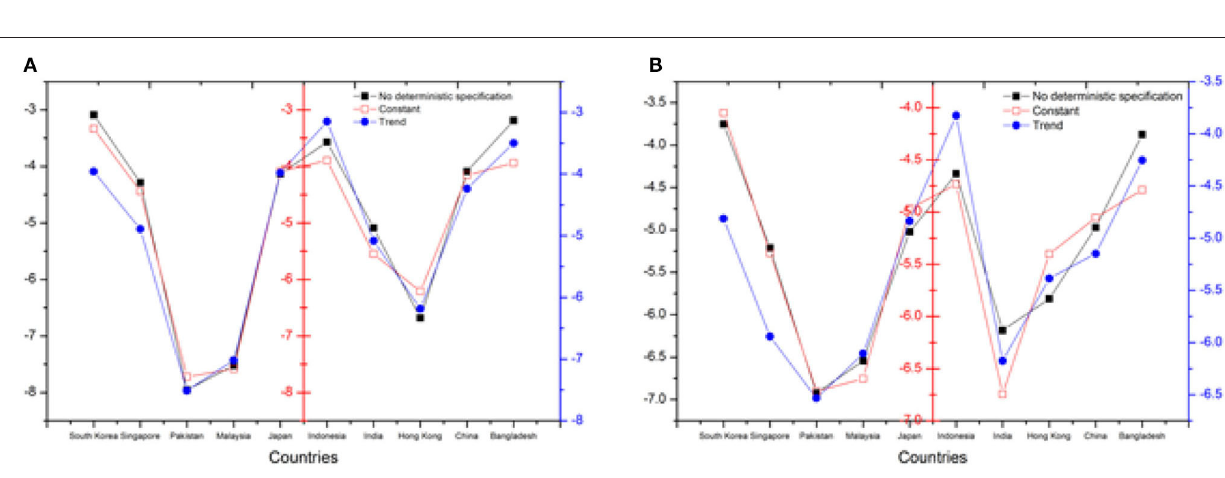
FIGURE 4 | Results of Banerjee and Carrion-i-Silvestre (57) cointegration analysis (A) DV: EG, (B) DV: CE.